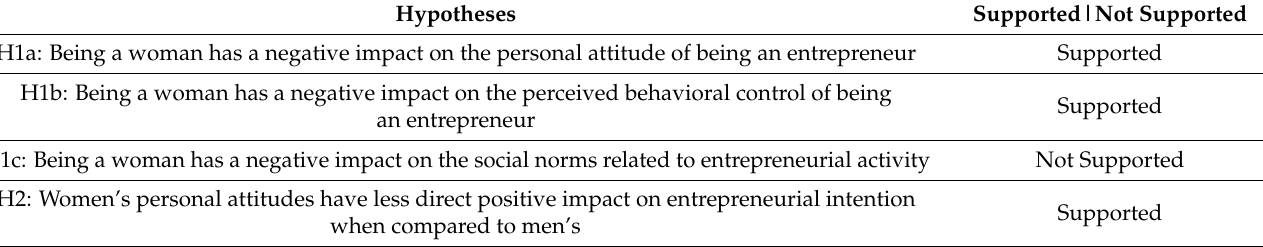
Table 7. Summary of